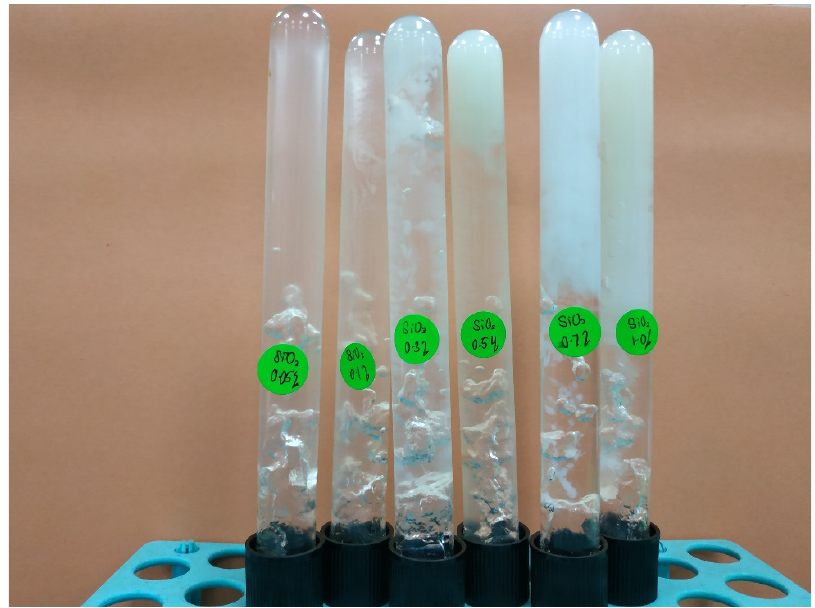
Figure 8. Photo of the formed PAM/PEI polymer gel with different concentrations of silica NP at retarder 5 wt% and salinity 30,000 ppm.